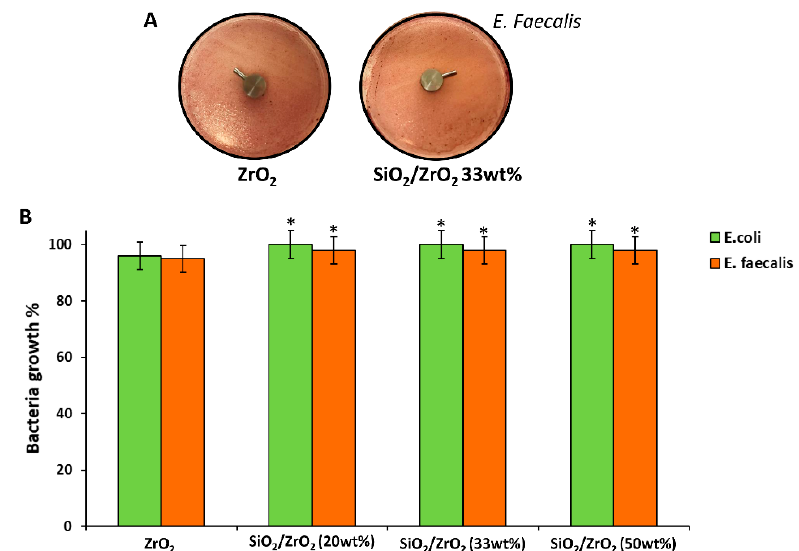
Figure 11. ( A ) Representative image of E. faecalis incubated with Ti-4 disks coated with ZrO 2 and SiO 2 /ZrO 2 (33 wt.%). ( B ) Bacteria growth (%) of E. coli and E. faecalis incubated with ZrO 2 , SiO 2 /ZrO 2 (20 wt.%), SiO 2 /ZrO 2 (33 wt.%) and SiO 2 /ZrO 2 (50 wt.%). Values are the mean standard deviation of measurements carried out on samples analyzed three times. The means and standard deviations are shown. *, p < 0.05 versus the bacteria treated with different composites.